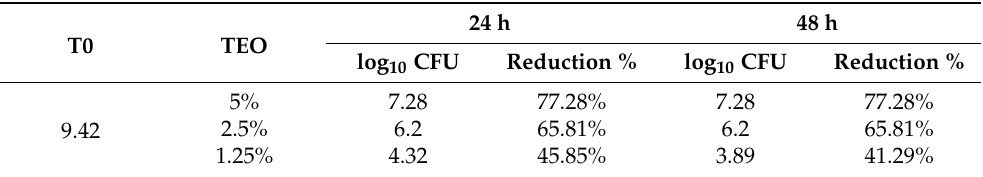
Table 4. Total mesophilic bacteria, expressed as log 10 CFU/g, in broiler litter before (T0) and 24 h and 48 h after treatment with TEO at different concentrations (5%, 2.5%, 1.25%), with relative percentage reduction in growth (%) compared to the positive control.